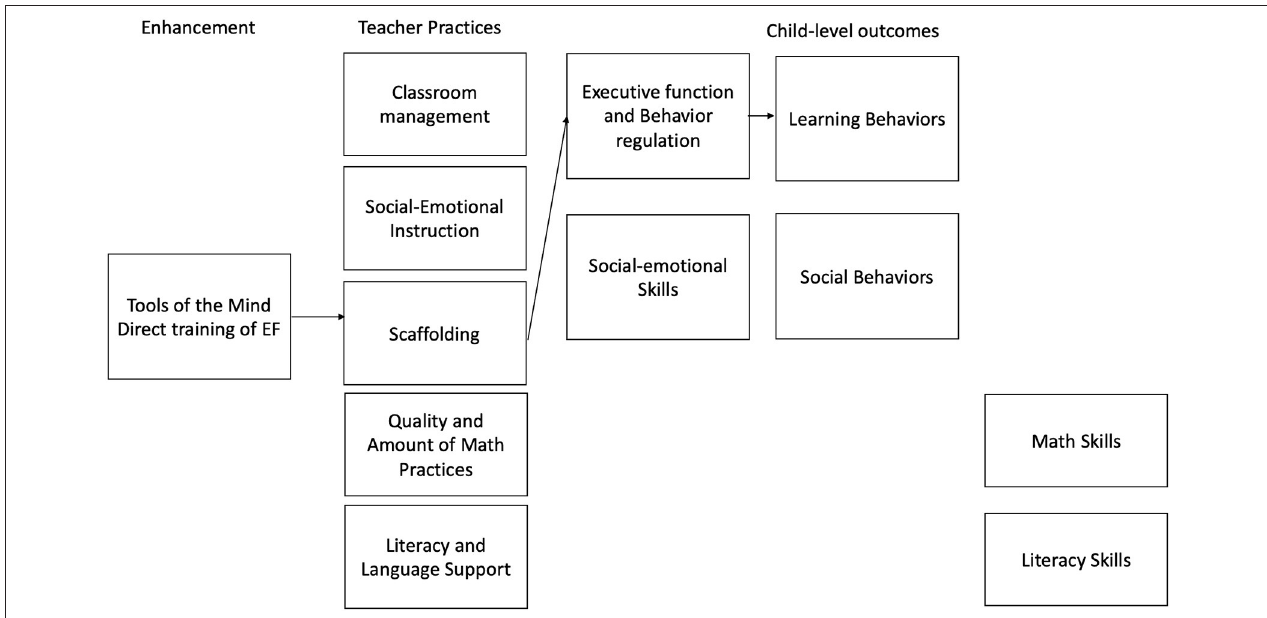
FIGURE 3 | Hypothesized theory of change for promoting play and direct training